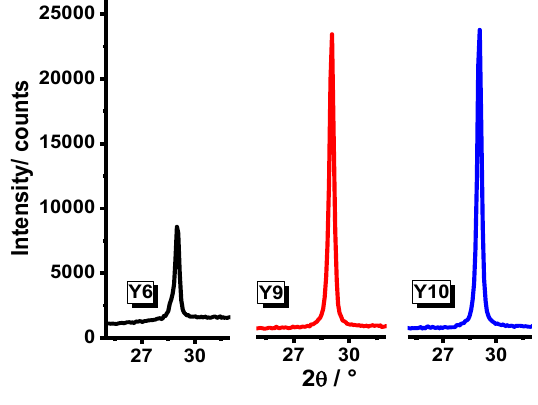
Figure 5. XRD pattern of Y 2 O 3 powder synthesized from yttrium chloride in the presence and absence of P-123 poloxamer heat-treated at 900 °C for 1